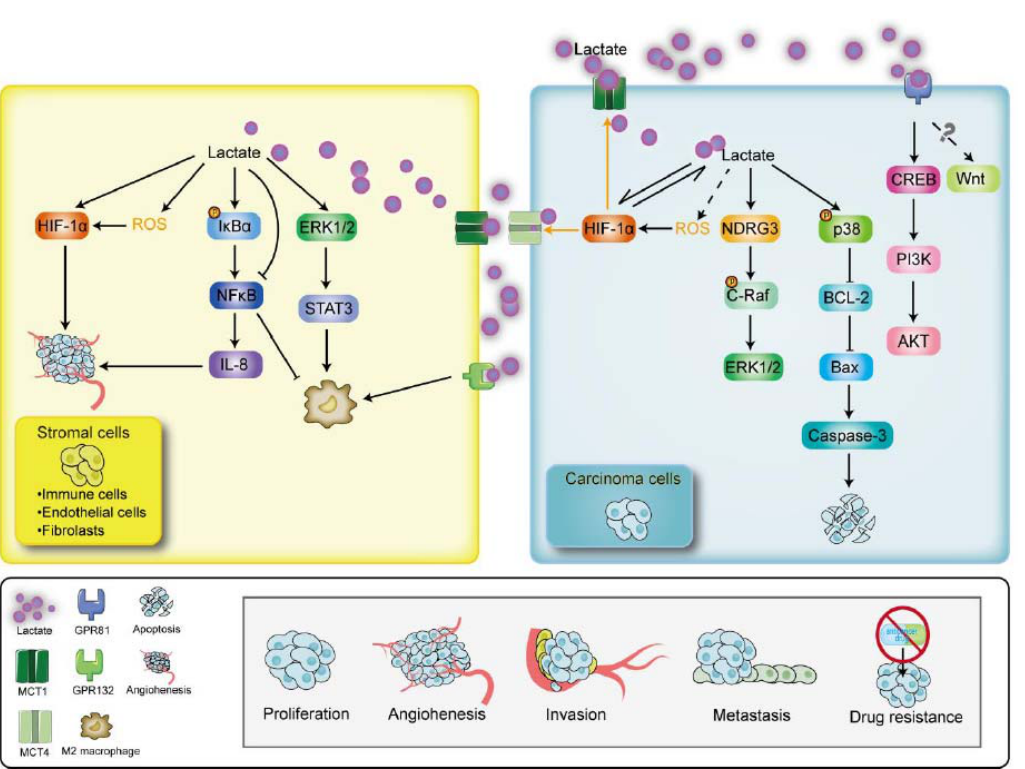
Figure 3. The downstream signalings of lactate mediation in cancer. Lactate production in the TME can mediate the signaling molecules in both stromal and carcinoma cells. In stromal cells, lactate can stimulate the HIF-1 α , ROS, I κ B α , and ERK1/2. In carcinoma cells, lactate can influence the HIF-